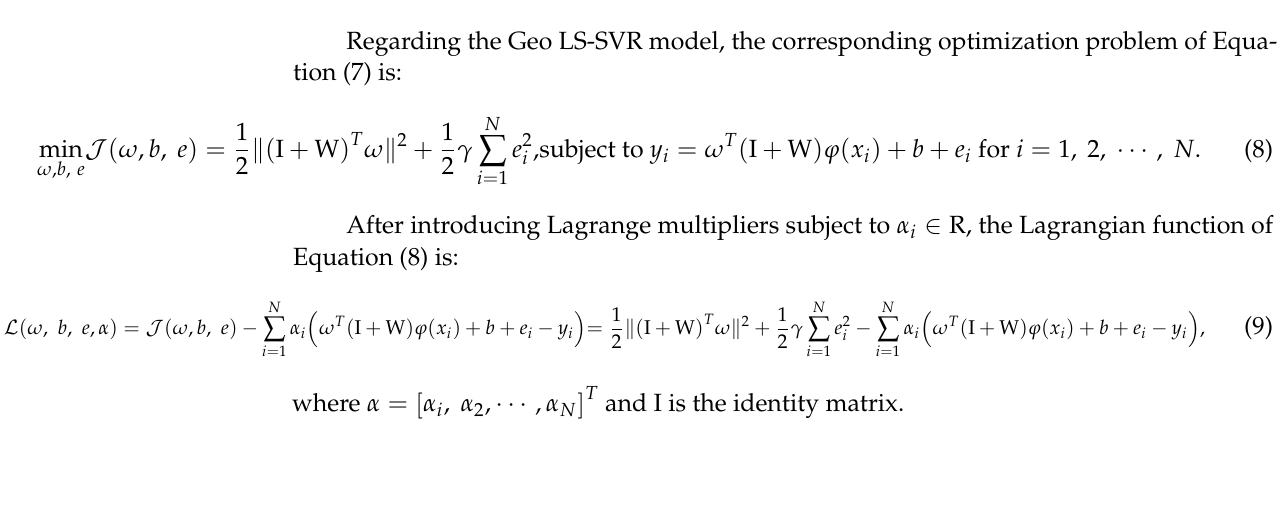
Figure 2. Relationship among the input, feature and geographic